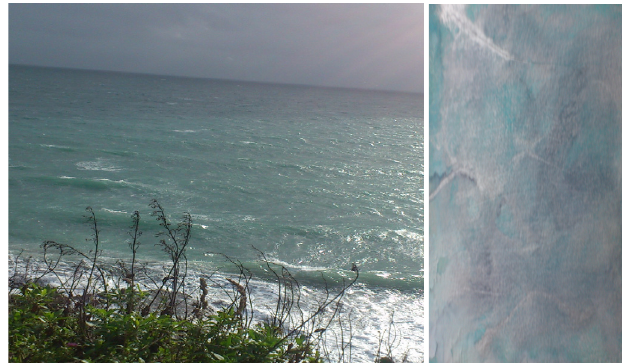
Figure 5. Glas coloured Irish Sea and glas on paper, 2014. © Silvia Loeffler, Glas Journal, 2015. Glas as a colour in old Irish and in Welsh is also used for grassy patches and the skin tone of dead animals, both rather confined, opposed to the general idea of “the boundless, infinite sea” [23], but in its liquid function it could not be applied to the Pacific, for instance, or to the Mediterranean Sea, which Homer described as “winedark” in The Illiad